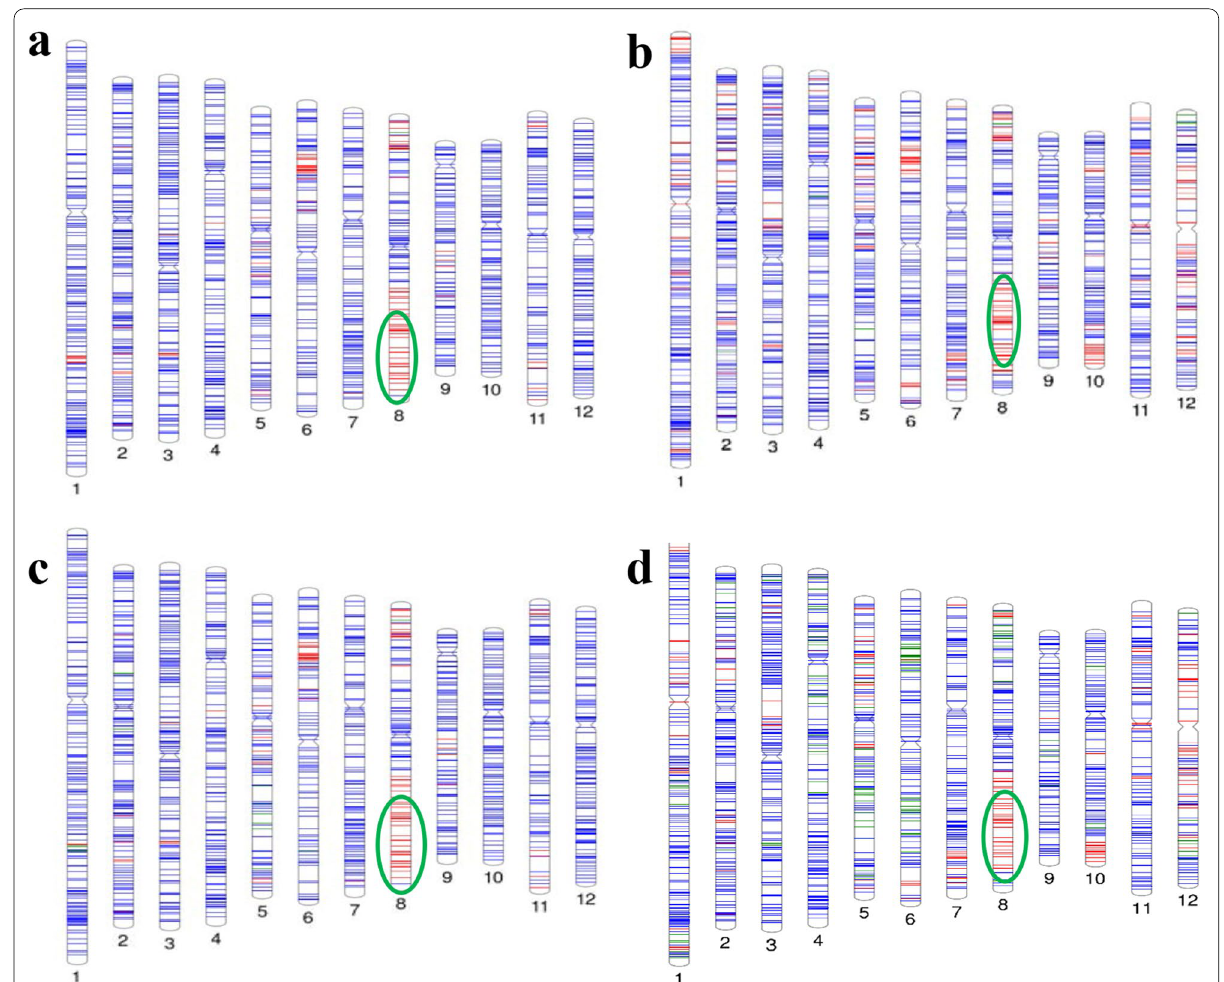
Fig. 4 Graphical genotype map of the improved maintainer lines a 91B‑42 and b 107B‑12 and the improved CMS lines c 91A‑18 and d 107A‑35. This map was constructed based on the genotypic data of the high‑density polymorphic SNP markers (Infinium 7 K SNP chip). Numbers below each chromosome indicate the respective chromosome number. Blue, red, and green lines indicate the recurrent parent, donor parent, and heterozygous SNP alleles, respectively. The qSTGL8.0 segment introgression is highlighted by a green circle